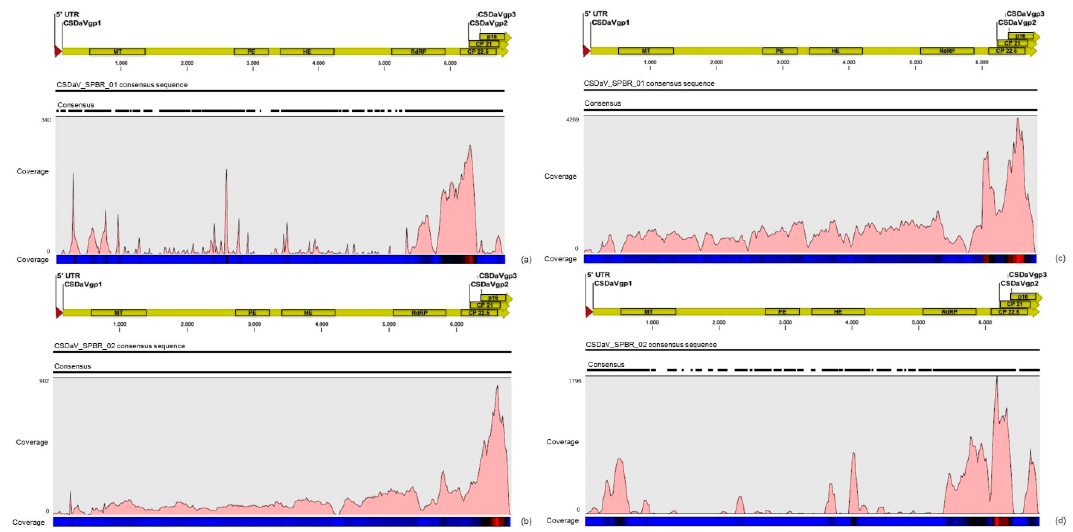
Figure 9. Profile distribution of reads from combined asymptomatic ( a , b ) and symptomatic ( c , d ) libraries along the two CSDaV consensus sequence obtained in this study: CSDaV_SPBR_01 ( a , b ); and CSDaV_SPBR_02 ( b , d ). Genome organization of the CSDaV references is shown above the respective graphic. Color scale varies from 0 (light blue color) to 100% (red color) of coverage.